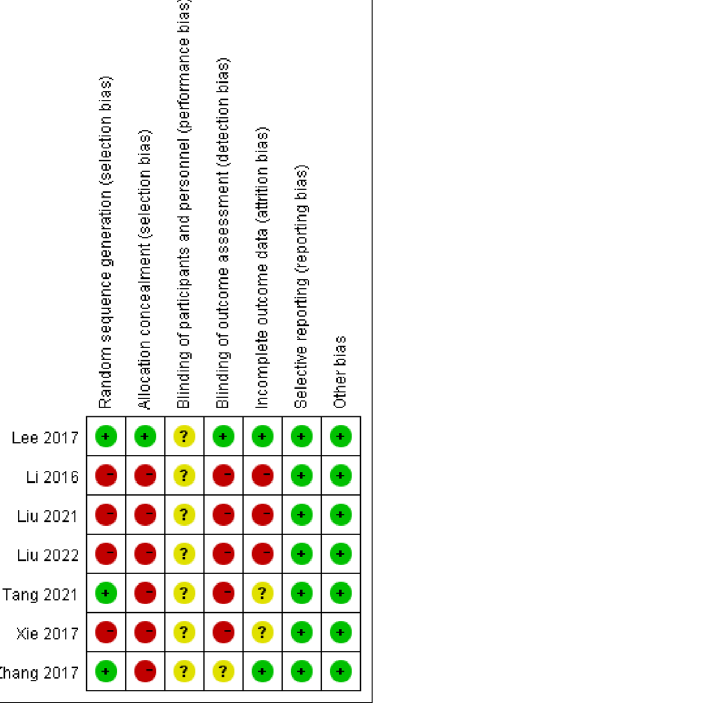
Figure 3. Risk of bias graph: review authors’ judgments about each risk of bias item presented as percentages across all included studies. Green: Low risk of bias; Yellow: Unclear risk of bias; Red: High risk of bias [32,47–52].